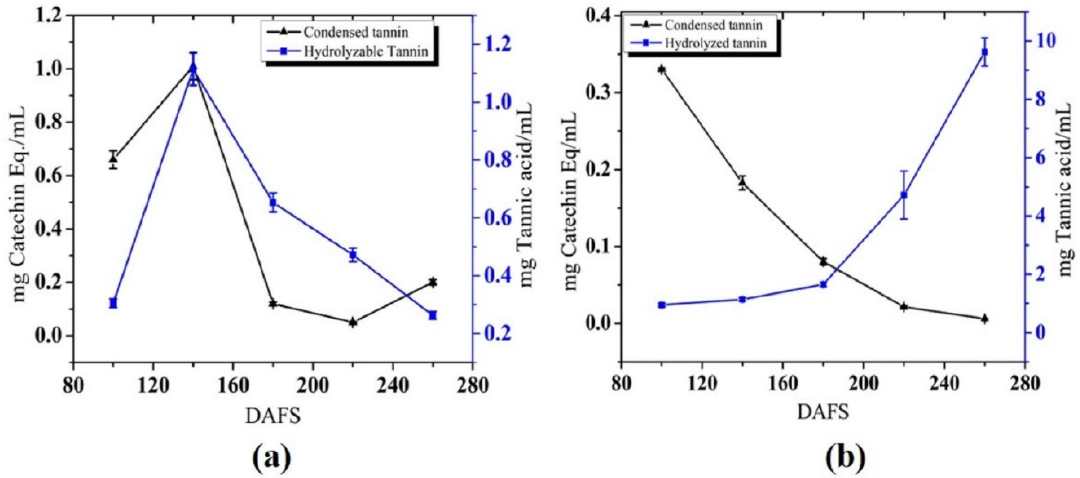
Figure 5. Tannin content in juice in ( a ) 2018; and ( b ) 2019. DAFS; days after fruit set.